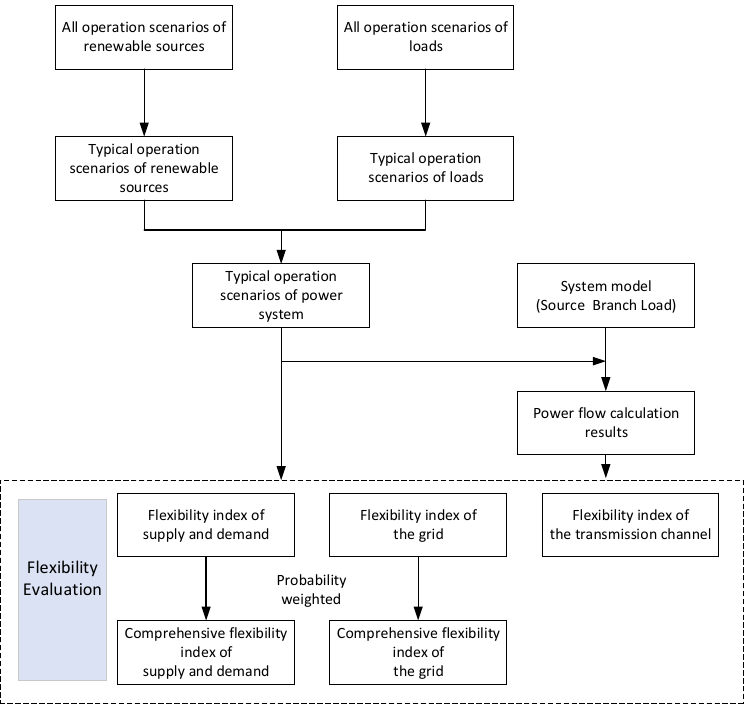
Figure 6. Flow chart of flexibility evaluation.